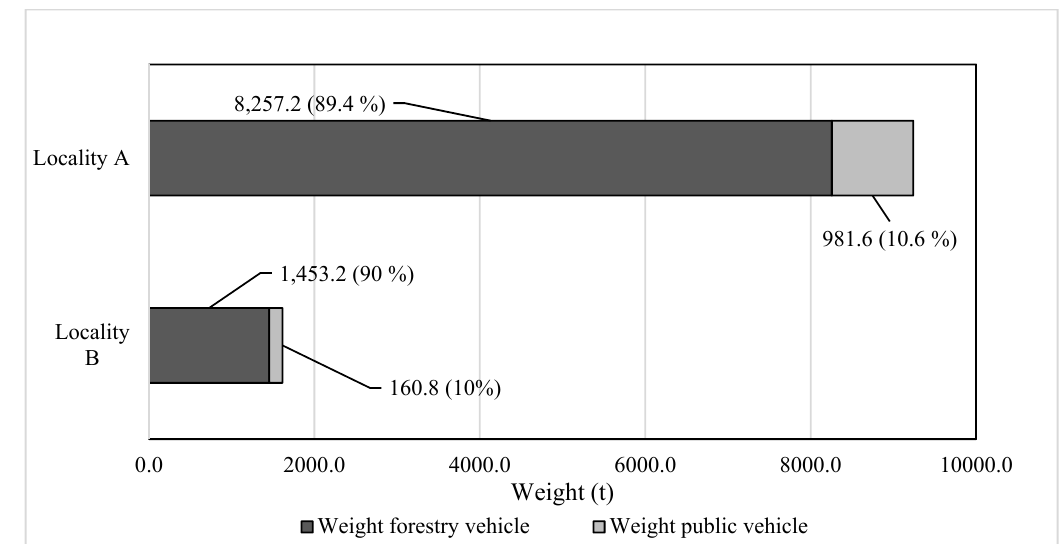
Figure 9. Comparison of traffic loads from passages of forestry practice and public vehicles.